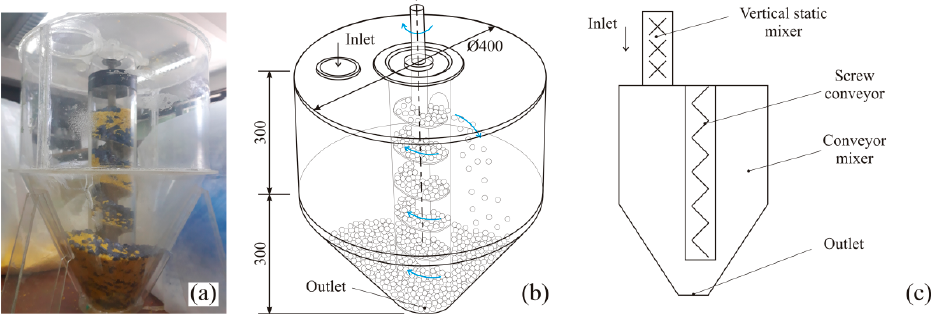
Figure 2. The blending material used for blending experiments ( a ), the blending conduct, (binary mixture of limestone particles, diameters 1 ÷ 2 and 3 ÷ 4 mm), after pre-mixing with three elements, ( b ), following the vertical static mixer equipped with five elements ( c ).